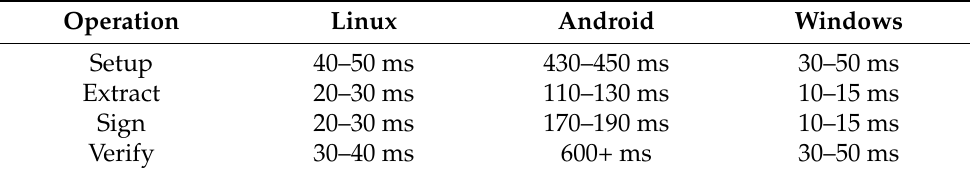
Table 3. BLMQ signature scheme overhead under Windows, Android, and